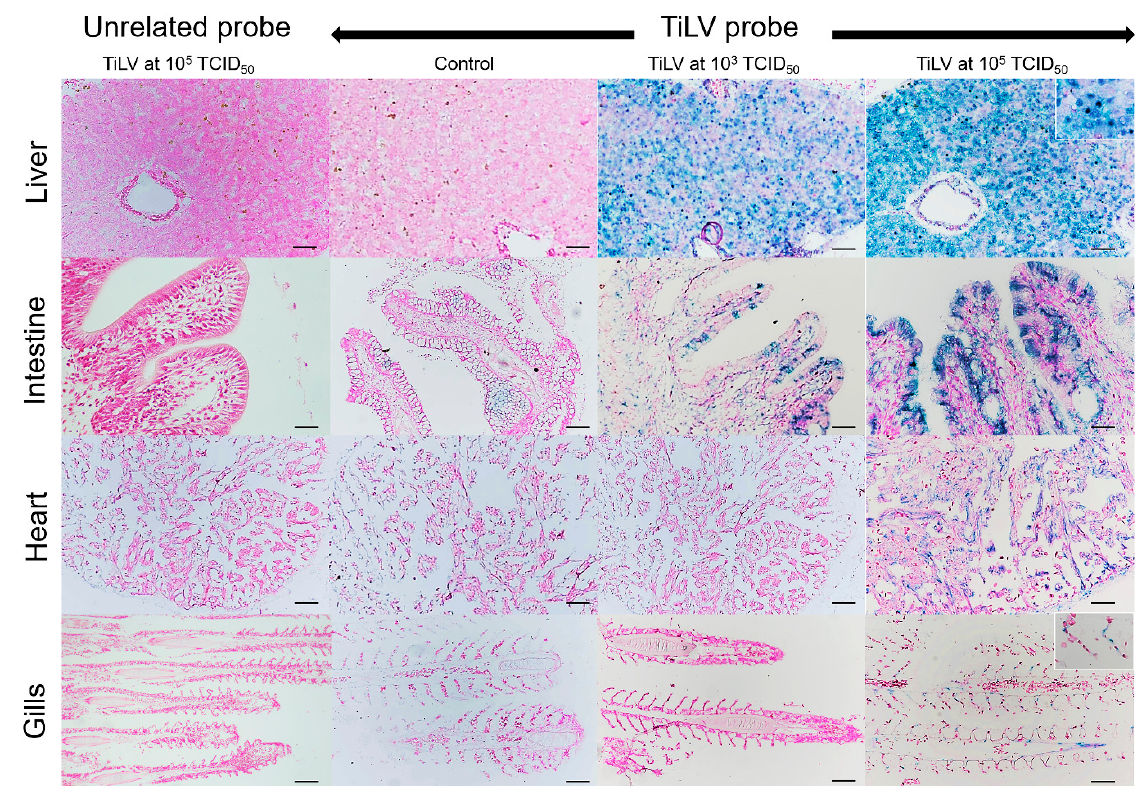
Figure 4. In situ hybridization (ISH) of TiLV RNA detection in Mozambique tilapia inoculation of TiLV at 1 × 10 3 TCID 50 /mL and 1 × 10 5 TCID 50 /mL concentrations. The TiLV RNA was detected in liver and intestinal epithelium of TiLV-infected Mozambique tilapia in both inoculation concentrations. The TiLV RNA labelling was evidence in the nucleus of hepatocytes (above inset), intestinal epithelium, myocardium, and gills epithelium (lower inset) of experimental Mozambique tilapia inoculation with TiLV at 1 × 10 5 TCID 50 /mL concentration. No evidence of hybridization signal was observed in the control fish and in the TiLV-infected Mozambique tilapia sections inoculation with CBoV-2 probe (unrelated probe). Bars indicate 120 µm.